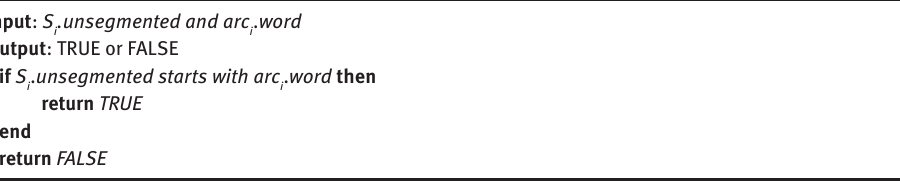
Algorithm 3: Judge Passable Forward Arcs in Genuine CLSI